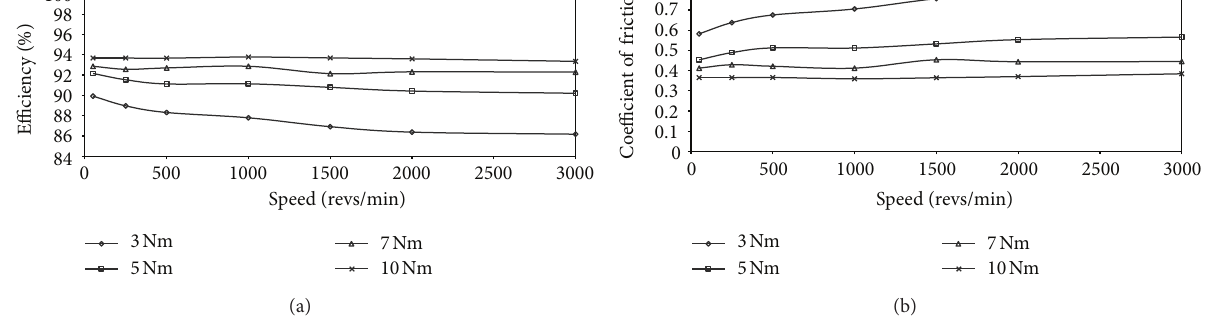
pressure angle PEEK/steel gear combinations. ∘